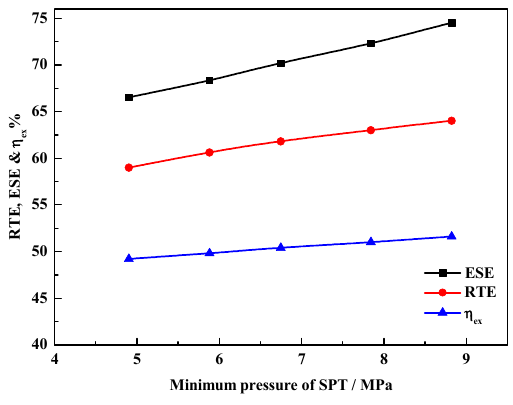
Figure 10. Effect of SPT minimum pressure on ESE, RTE, and η ex.